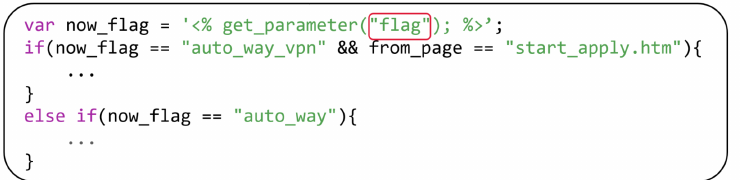
Figure 3. The code snippet of the QIS_internet_ip.htm page in RT-N53 router, “flag” is the front-end parameters used for logical